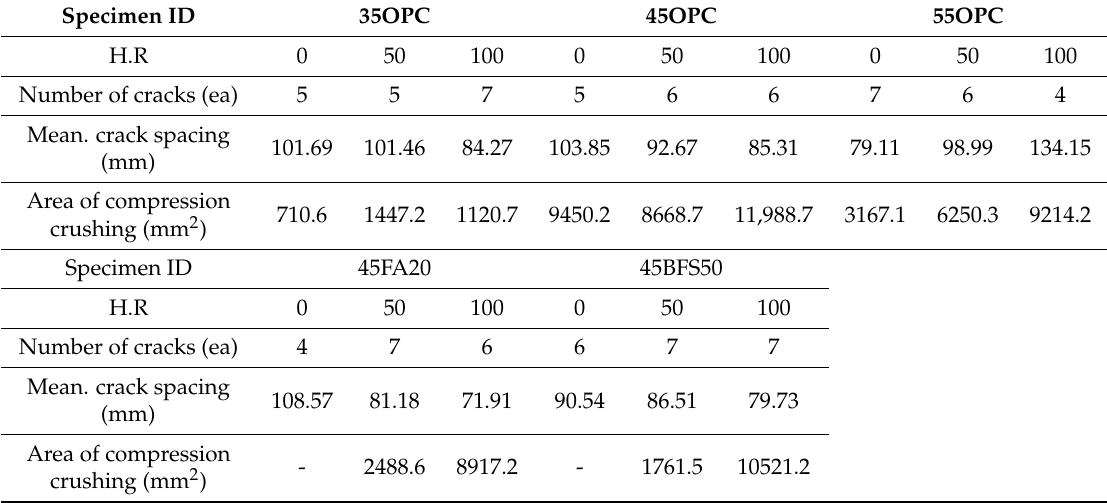
Table 6. Results of experimental test for RC member